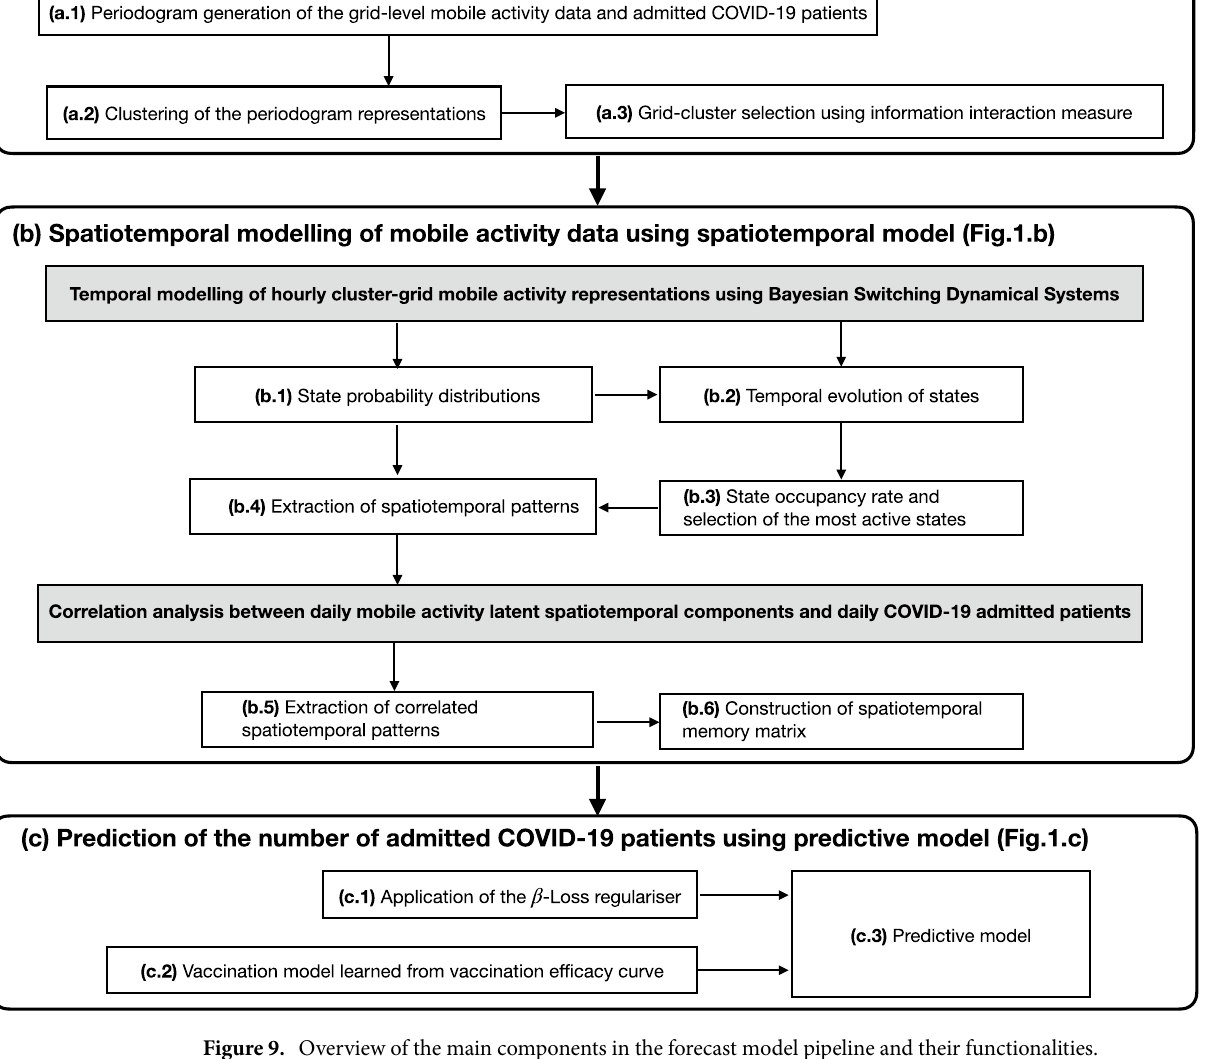
Figure 9. Overview of the main components in the forecast model pipeline and their